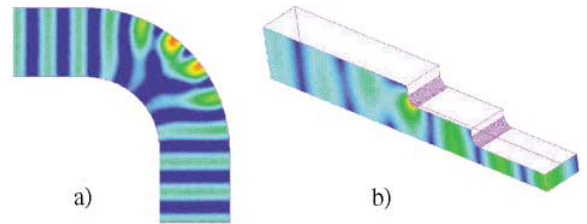
FIG. 7. (Color) Simulated electric field plots in (a) the over- height E-plane bend and (b) quarter geometry of a height taper.